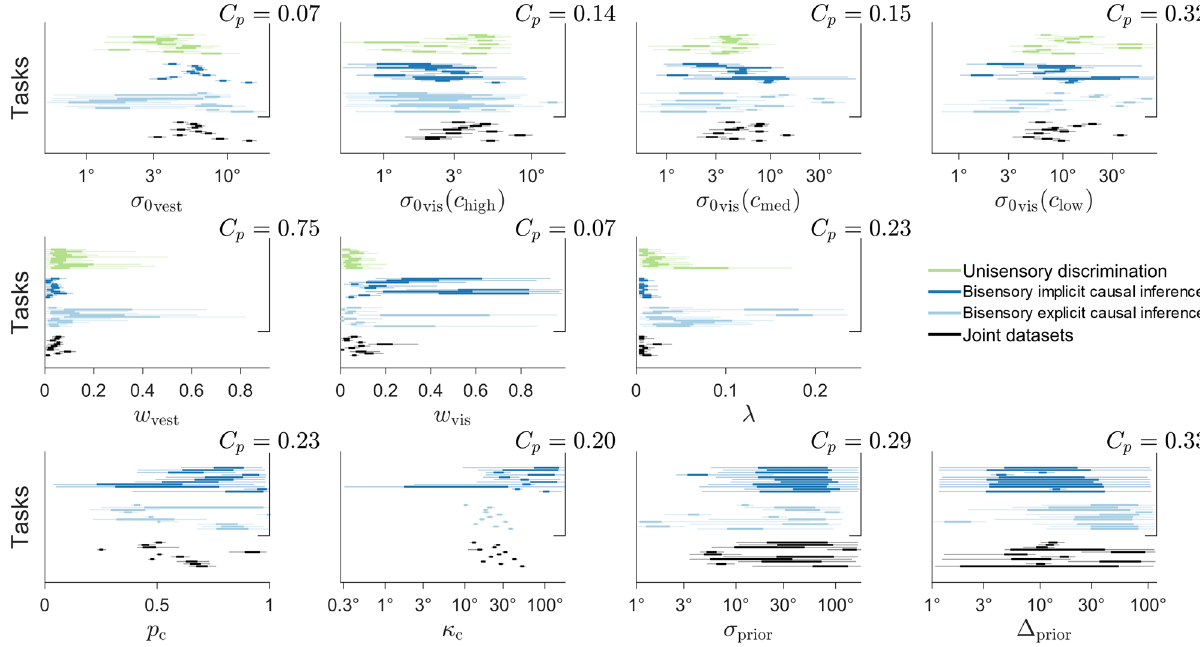
Fig 5. Posteriors over model parameters. Each panel shows the marginal posterior distributions over a single parameter for each subject and task. Each line is an individual subject’s posterior (thick line: interquartile range; light line: 95% credible interval); different colors correspond to different tasks. For each subject and task, posteriors are marginalized over models according to their posterior probability (see Methods). For each parameter we report the across-tasks compatibility probability C , that is the (posterior) probability that subjects were best described by the assumption that p parameter values were the same across separate tasks, above and beyond chance. The first two rows of parameters compute compatibility across all three tasks, whereas in the last row compatibility only includes the bisensory tasks (bisensory inertial discrimination and unity judgment), as these parameters are irrelevant for the unisensory